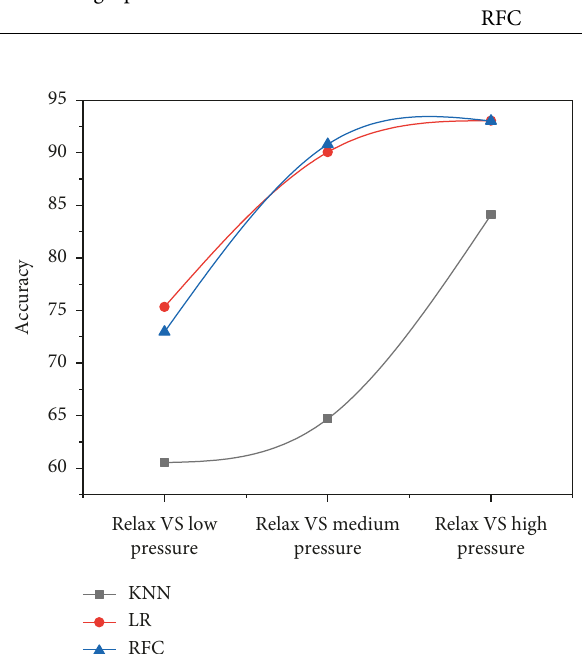
Figure 10: Comparison of classification accuracy of three classifiers under relaxation and different stress